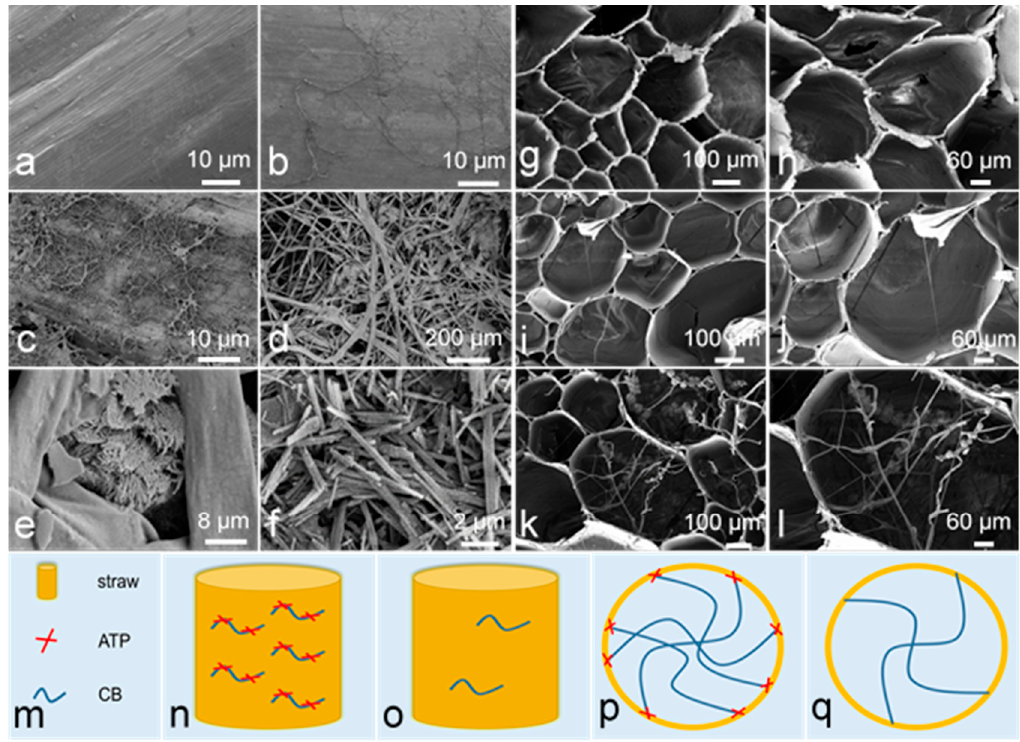
Figure 7. SEM images of ( a ) longitudinal section of wheat straw, ( b ) BM on longitudinal section of wheat straw, ( c – e ) SRA on longitudinal section of wheat straw, ( f ) attapulgite (ATP), ( g , h ) cross section of wheat straw, ( i , j ) BM in cross section of wheat straw, and ( k , l ) SRA in cross section of wheat straw. Schematic diagram of anchoring effect of SRA or BM on longitudinal ( n , o ) and cross sections ( p , q ) of wheat straw with notes ( m ).